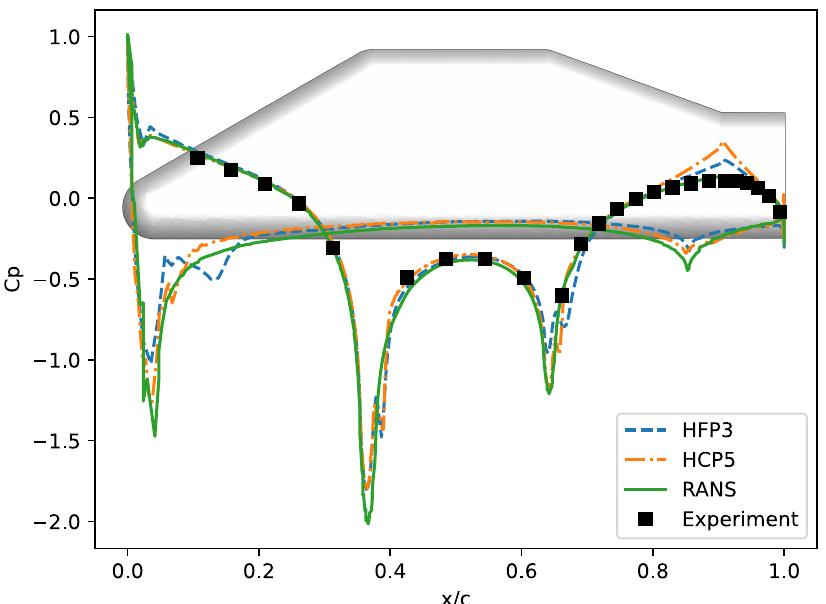
Figure 6. Comparative results between the Cp plot over the centrelines of HFP3, HCP5, RANS and the experiments from [7].